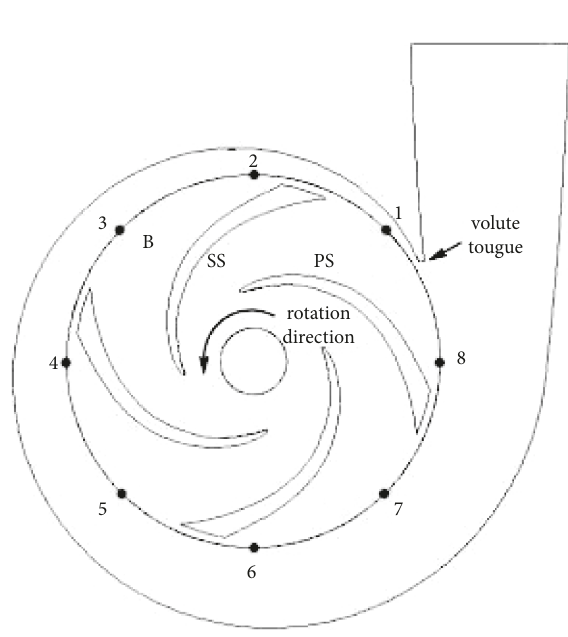
Figure 3: Distributions of monitoring